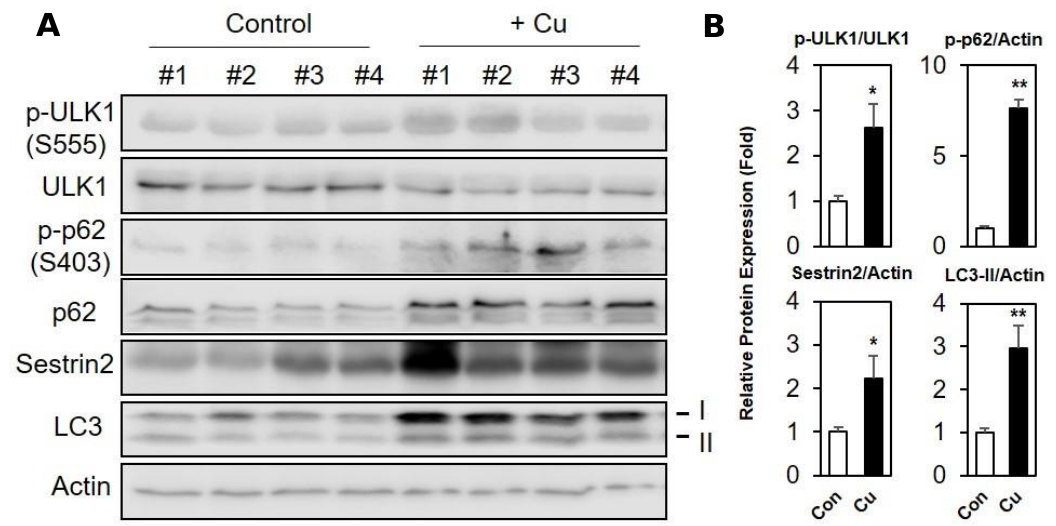
Figure 6. Cu treatment increases expression of Sestrin2 and facilitates ULK1 and p62 phosphorylations in mouse liver. ( A ) C57BL / 6 mice (B6 male, 8 weeks old) were injected orally with 0.29mg / kg CuCl 2 or saline for 6 h ( n = 4 for each group). Liver tissues were collected, and total liver lysates were subjected to immunoblot analysis for phospho-ULK1 S555, total ULK1, phospho-p62 S403, total p62, Sestrin2 and LC3 in liver tissue. β -actin (Actin) were used as loading controls. ( B ) Each immunoblot band intensity was analyzed by Image J, as indicated. * p < 0.05, ** p < 0.01. p -value is from Student’s t